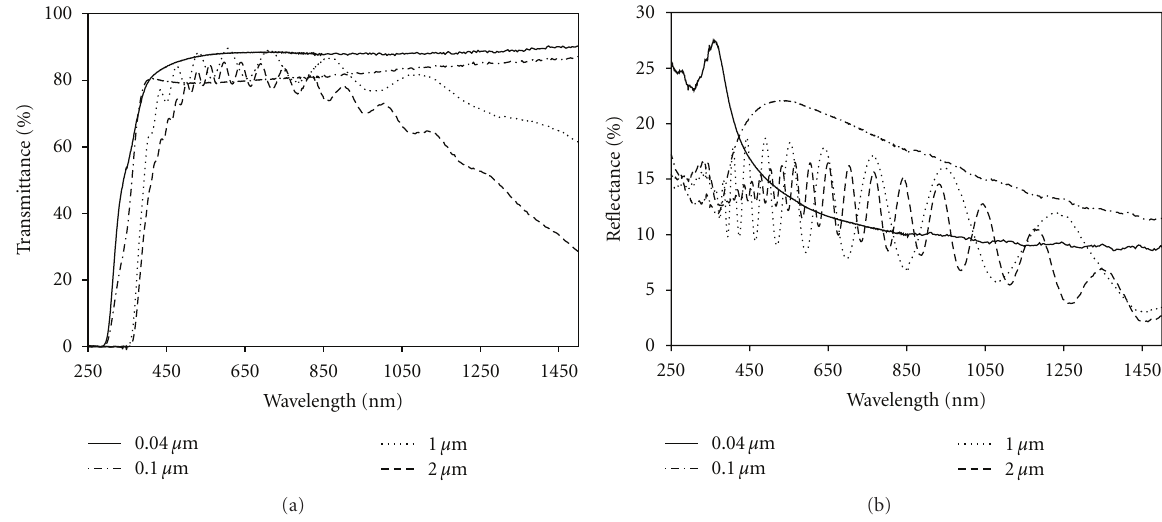
Figure 3: (a) Transmittance and (b) reflectance data for the ZnO:Al 2 O 3 films of di ff erent thickness.